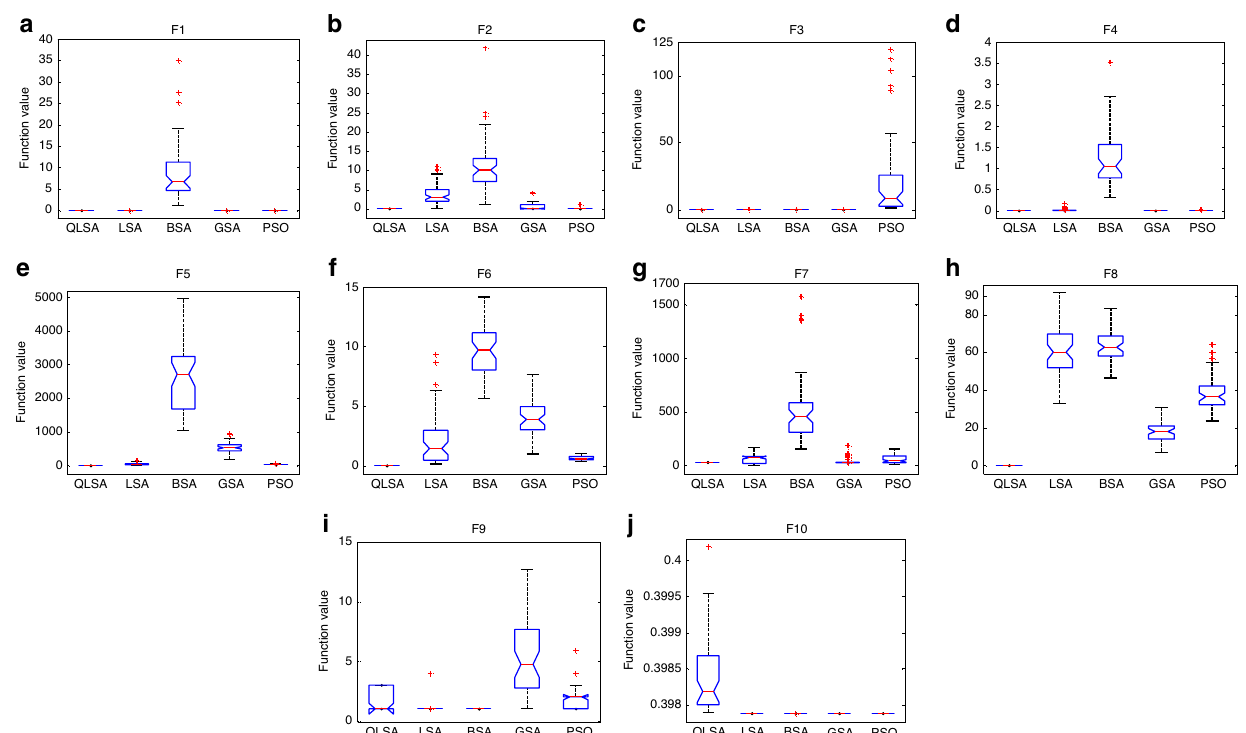
Fig. 1 The global optimization performance assessment of QLSA, LSA, BSA, GSA and PSO under different benchmark functions. a The global optimisation results for QLSA, LSA, BSA, GSA and PSO in benchmark function F1 (Sphere) is obtained based on dimension problem, search space and function minimum (Supplementary Table 1). b The global optimisation results for QLSA, LSA, BSA, GSA and PSO in benchmark function F2 (Step) is obtained based on dimension problem, search space and function minimum (Supplementary Table 1). c The global optimisation results for QLSA, LSA, BSA, GSA and PSO in benchmark function F3 (Quartic). d The global optimisation results for QLSA, LSA, BSA, GSA and PSO in benchmark function F4 (Schwefel 2.22). e The global optimisation results for QLSA, LSA, BSA, GSA and PSO in benchmark function F5 (Schwefel 1.2). f The global optimisation results for QLSA, LSA, BSA, GSA and PSO in benchmark function F6 (Schwefel 2.21) is obtained based on dimension problem, search space and function minimum (Supplementary Table 1). g The global optimisation results for QLSA, LSA, BSA, GSA and PSO in benchmark function F7 (Rosenbrock). h The global optimisation results for QLSA, LSA, BSA, GSA and PSO in benchmark function F8 (Rastrigin). i The global optimisation results for QLSA, LSA, BSA, GSA and PSO in benchmark function F9 (Foxholes). j The global optimisation results for QLSA, LSA, BSA, GSA and PSO in benchmark function F10 (Branin) is obtained based on dimension problem, search space and function minimum (Supplementary Table